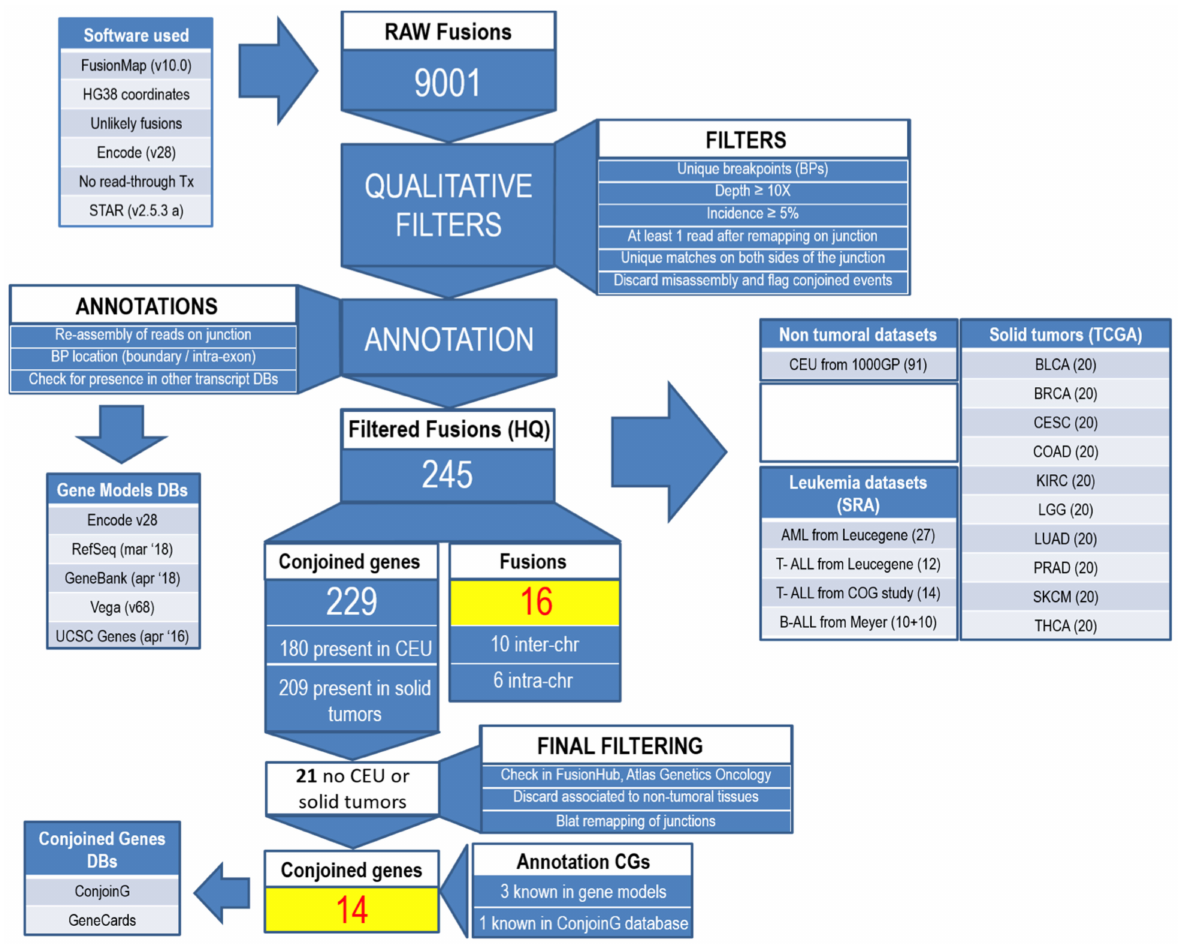
Figure 1. Bioinformatics